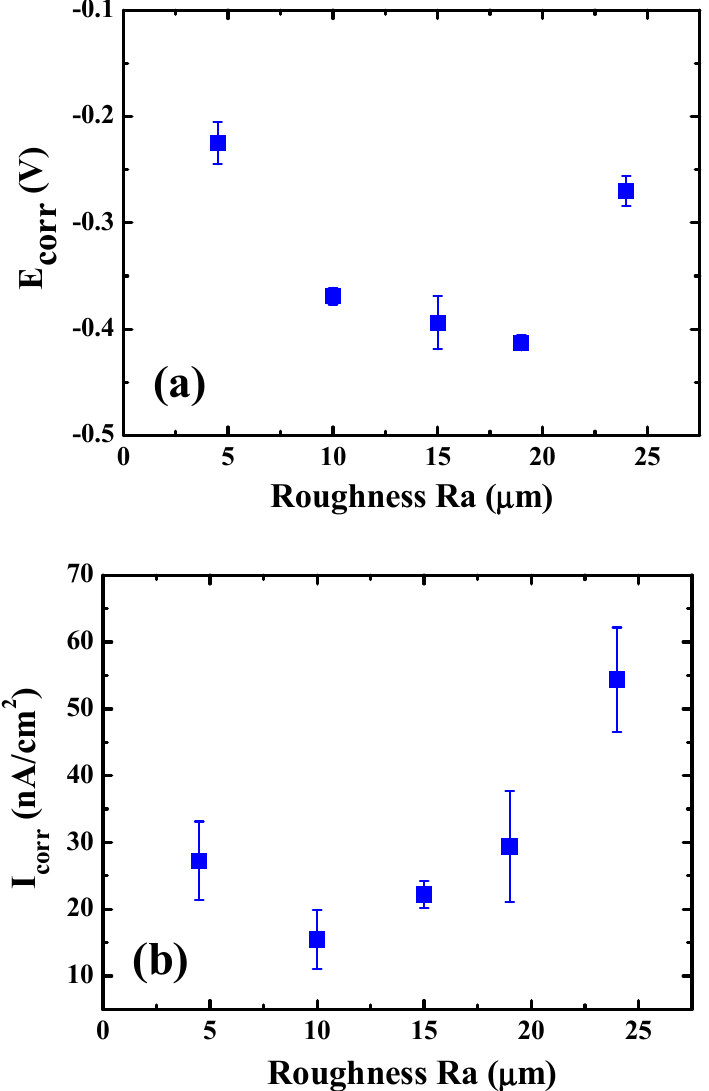
Figure 10. The variation of bio-corrosion ( a ) potential (E corr ) values and ( b ) potential (I corr ) values as a function of various surface roughness levels. The bio-corrosion activity appears to become more intense again when the roughness was smoothed by EP down to 4.5 µ m, a sign of over-